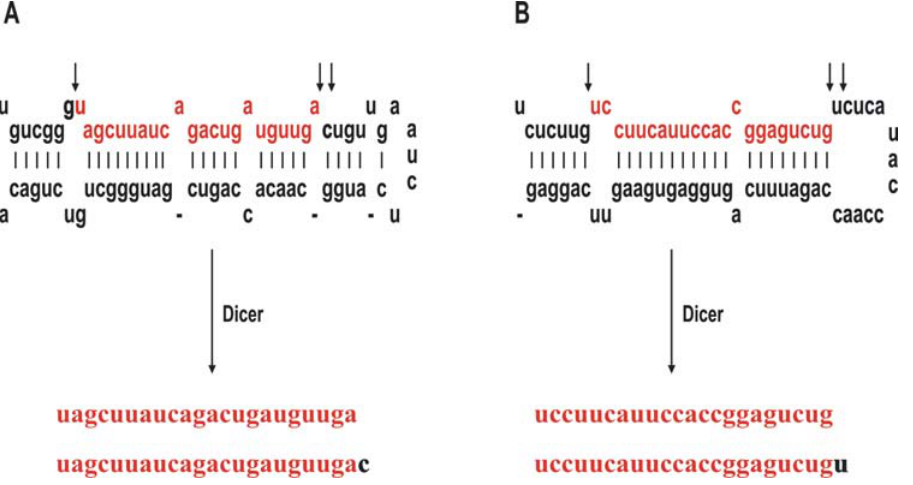
Figure 1. Wobble digestion of miRNAs by Dicer in CaSki cells. Arrows above the pre-miRNA indicate wobble-digestion sites on the pre–miR- 21 in A and pre-miR-205 in B , producing products with additional nucleotides on the 3 9 end. The sequences shown in red correspond to mature miRNA while that shown in black is the portion of pre-miRNA which is removed during processing.